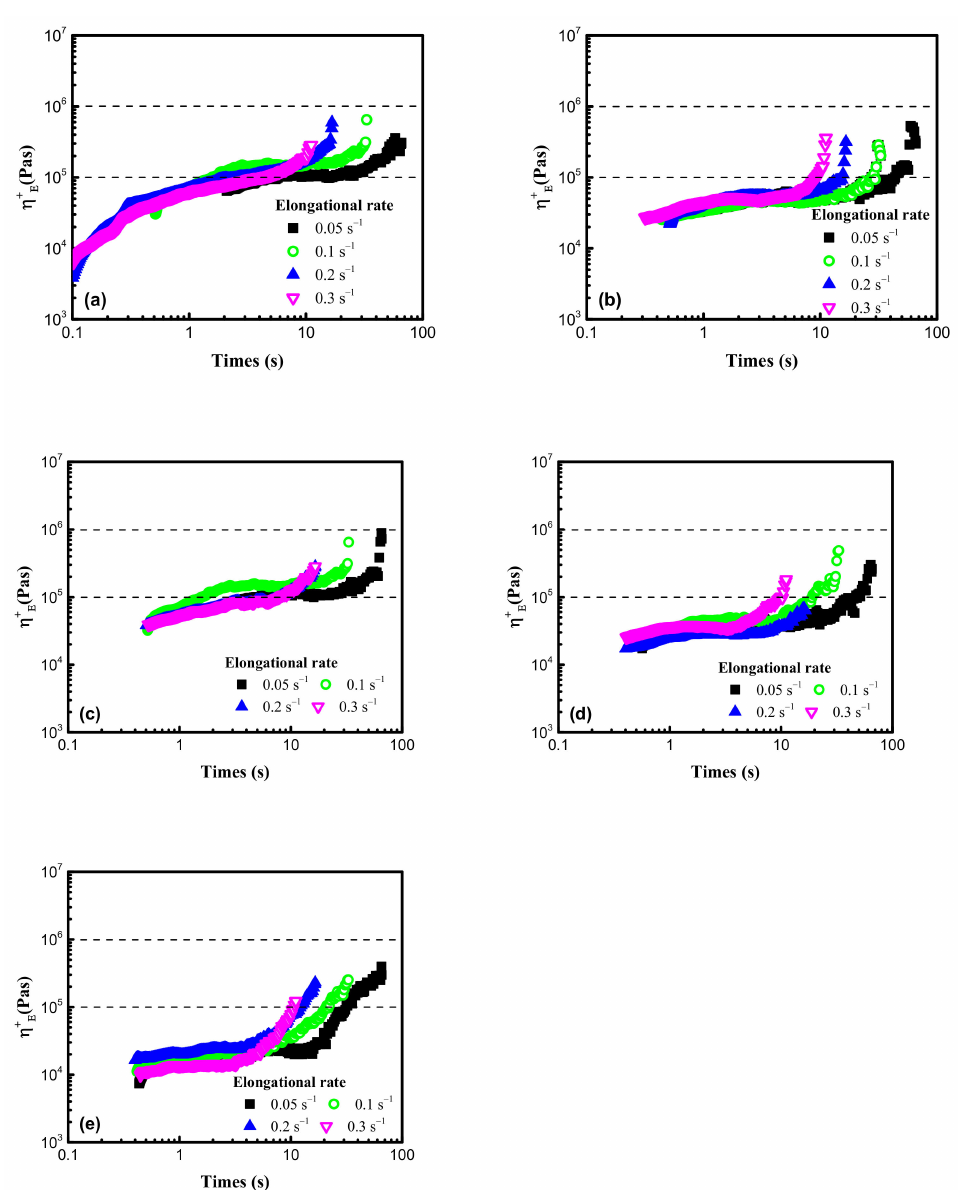
Figure 8. Elongational viscosities for 5 POE samples, at temperature of 150 ◦ C. ( a ) POE1; ( b ) POE2; ( c ) POE3; ( d ) POE4; ( e )